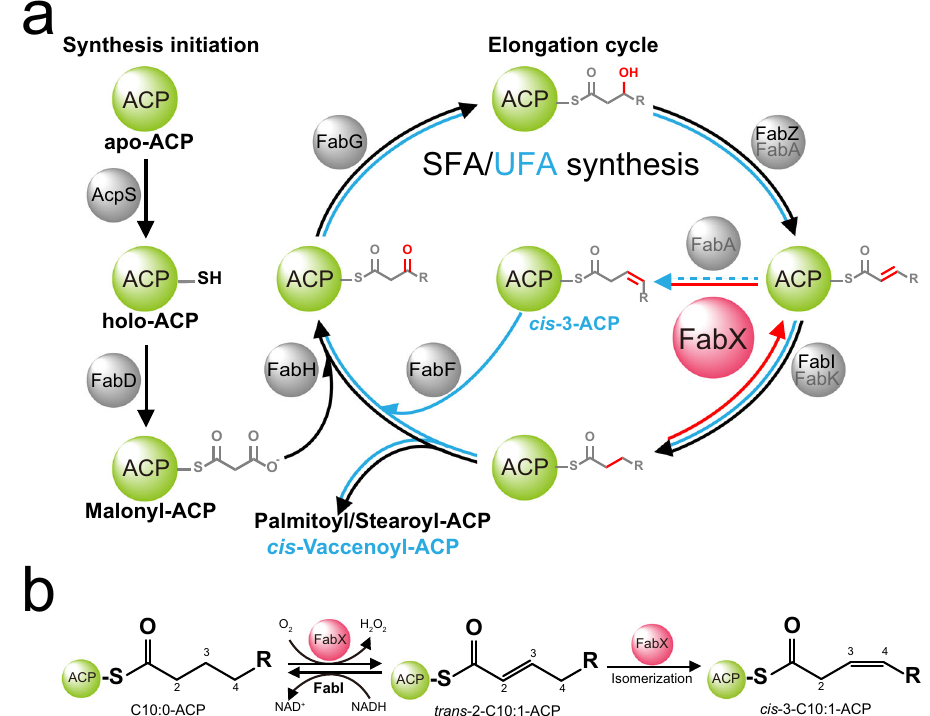
Fig. 1 Schematic diagram of fatty acid biosynthesis in H. pylori . a The SFA (black arrows) and UFA (blue arrows) biosynthesis pathways share the same initiation steps, but have distinct differences in the elongation cycle. In the initiation stage, apo form ACP (apo-ACP) is fi rstly activated to holo form ACP (holo-ACP) by acyl carrier protein synthase (AcpS), where the key residue Serine (Ser36 in H. pylori ) of apo-ACP is covalently attached by a phosphopantetheine group (PPant) derived from CoA. Malonyl-CoA:acyl carrier protein transacylase (FabD) transfers the initial three-carbon substrate to the thiol group of the PPant arm on holo-ACP. Subsequently, the Malonyl-ACP moves to the elongation cycle. For SFA synthesis, the